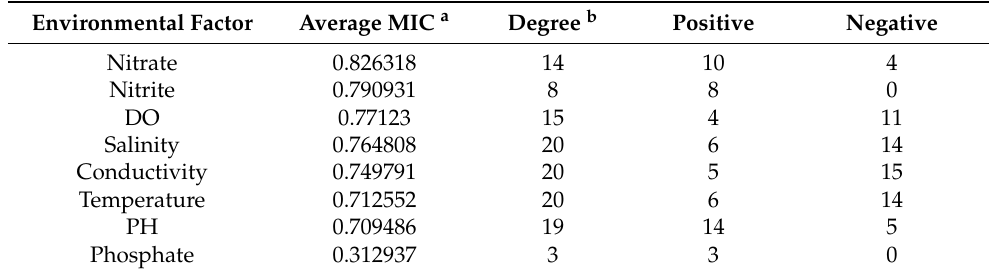
Table 4. Maximal Information-based Nonparametric Exploration (MINE) network of environ- mental parameters.